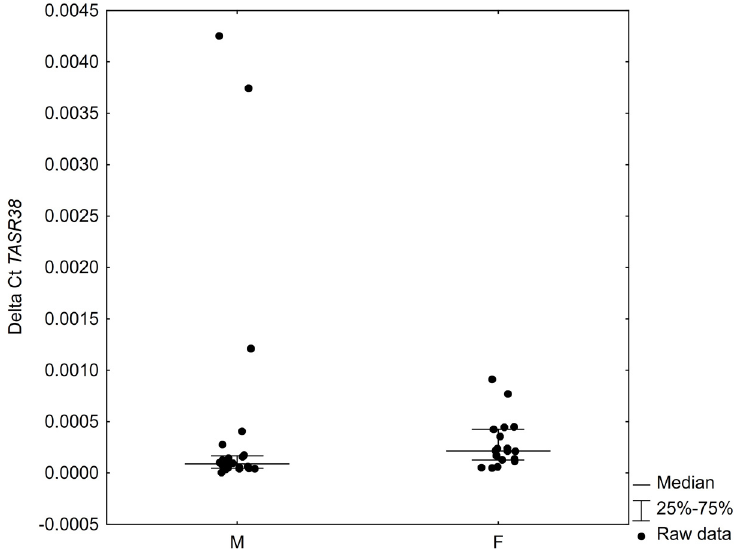
Figure 4. Difference between the sexes in TAS2R38 expression level in inferior turbinate mucosa p = 0.0195.